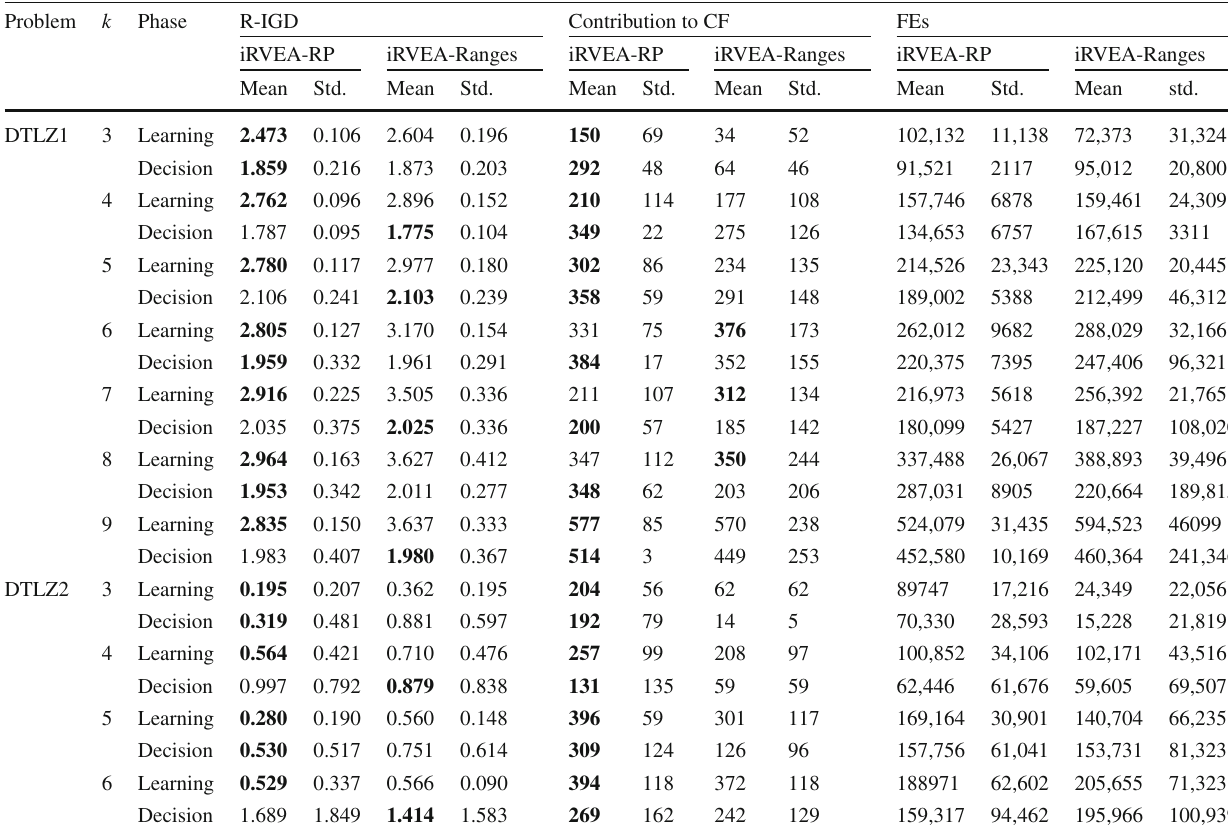
Table 4 iRVEA-RP vs. iRVEA-Ranges: numerical results with 100 generations per iteration for the objectives ranging from 3 to 9